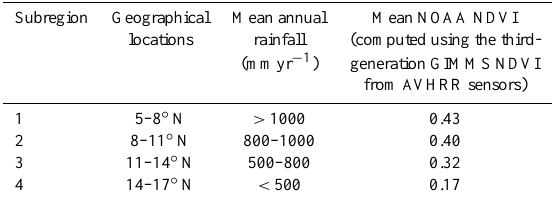
Table 1. Annual mean rainfall and mean NOAA NDVI over the four sub regions.